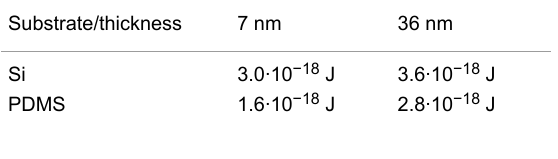
Table 1: Total FEA friction work at onset of sliding (2 nm X motion).